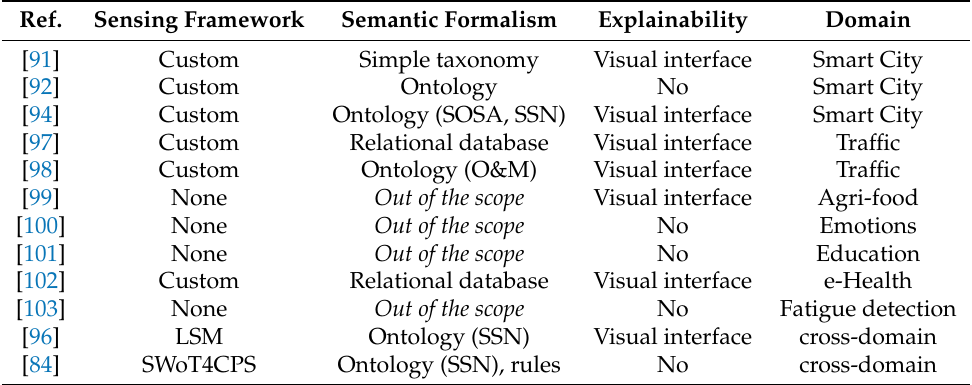
Table 1. Semantic Web of Things (SWoT) for Environmental Sensing [10,12,83,84].